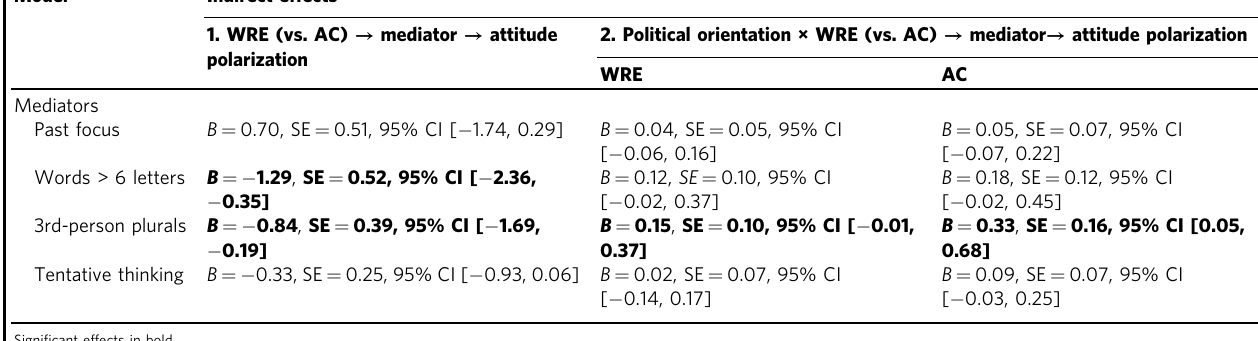
Table 2 Study 7: psycholinguistic variables as potential mediating mechanisms of the wise reasoning experimental (vs. active control)